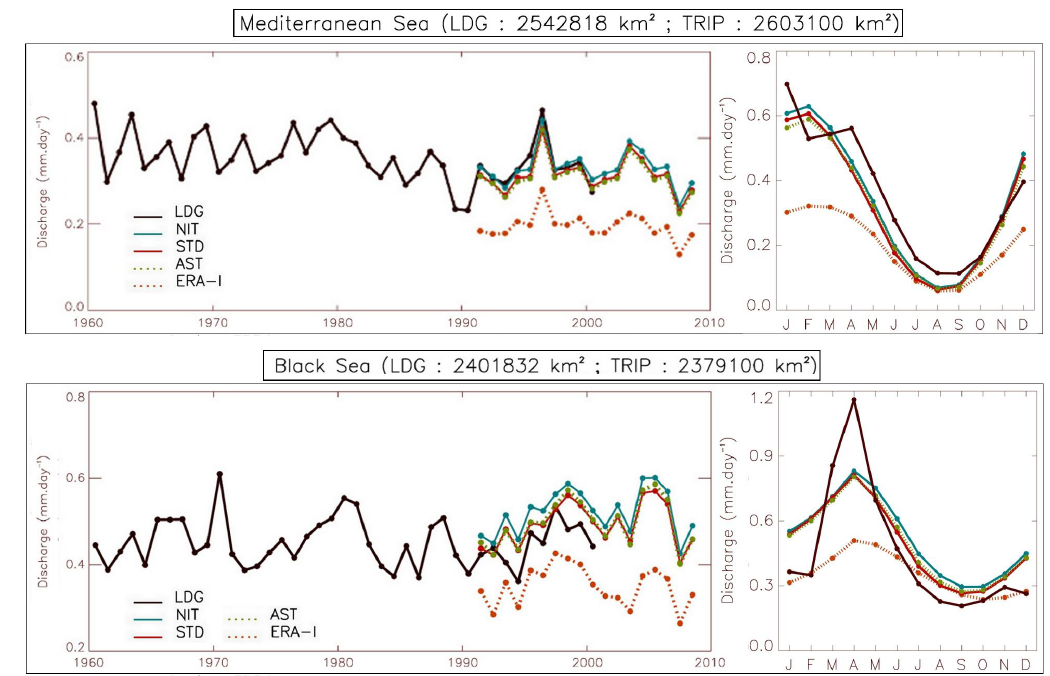
Fig. 13. Total (except for the Nile basin) river freshwater input to (top panel) the Mediterranean Sea, (bottom panel) the Black Sea, as estimated by (dark solid lines) Ludwig et al. (2009) from 1960 to 2000 (LDG), and as simulated in this study (coloured lines) using ERA-I, STD, AST, and NIT from 1991 to 2008: (left panel) annual time series, (right panel) mean annual cycle. The drainage areas used in LDG and in TRIP estimations are